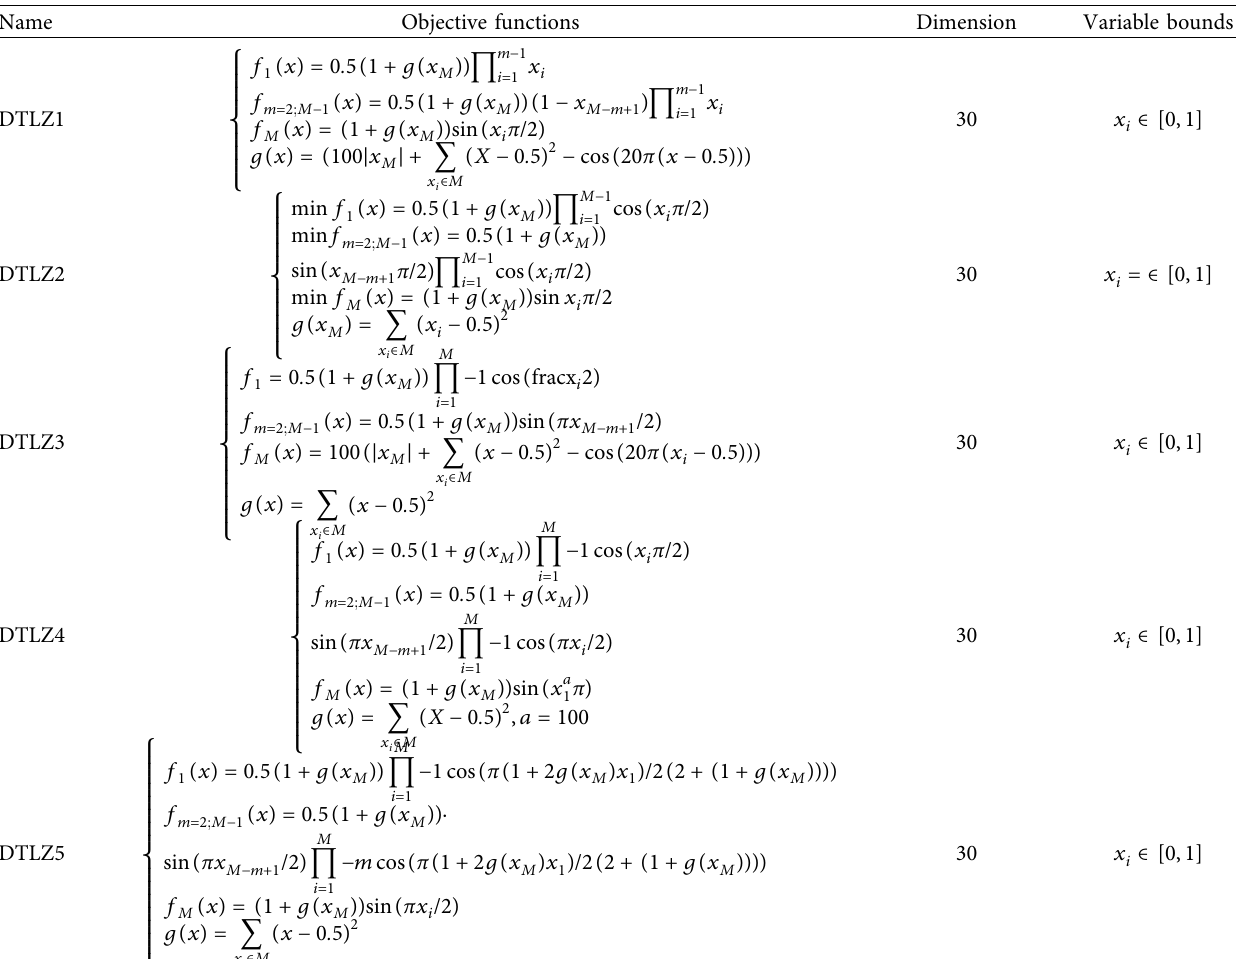
Table 3: Test functions: